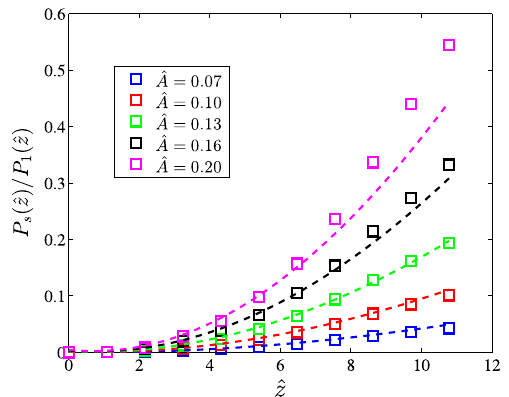
FIG. 4. The power ratio of the lower (top) and upper (middle) sidebands, and their sum (bottom) to the amplified seed along the undulator for different detunings (electron beam energy modu- lation wavelengths) according to 1D numerical simulations (solid lines). All dashed lines are the theory predictions of Eq. (24). The ˆ A ¼ 0 initial normalized energy modulation amplitude is . 13